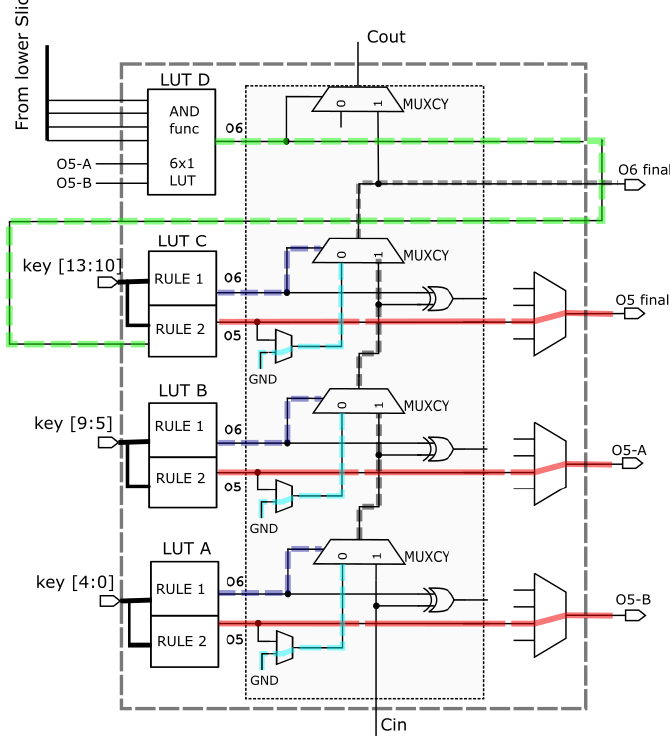
Figure 5. Mapping of a 2 × 14 TCAM to four 5 × 2 LUTs in a last